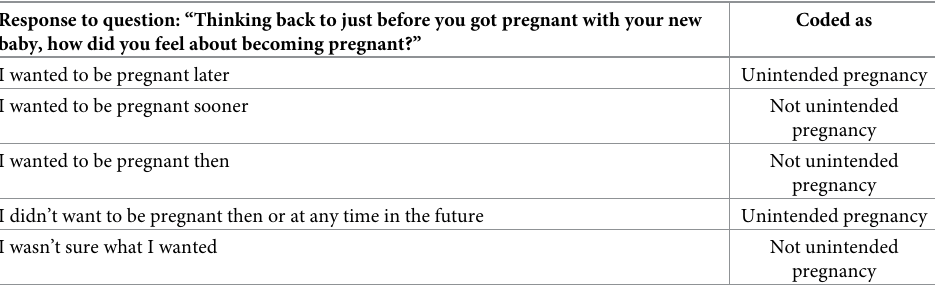
Table 1. Definition of the unintended pregnancy outcome